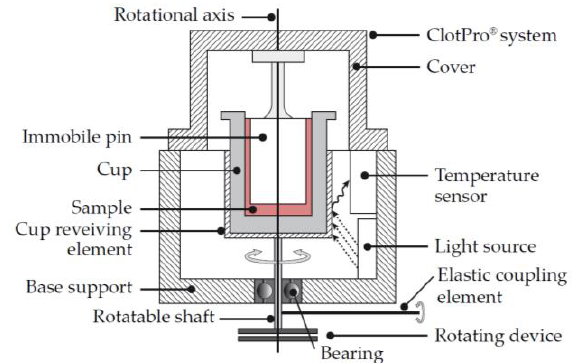
Figure 12. Schematic of the ClotPro ® system. The ClotPro ® system consists of a cup that contains the blood sample and a static pin, which is fixed to the cover. The cup rotates around the vertical axis, driven by an elastic coupling element, such as a spring wire, which is attached to the shaft. The light source (wavelength 1–3 µ m) is placed within 75 mm of the shaft and cup-receiving element to act as a temperature control device. Adapted from International Patent WO,2018 / 137766,A1